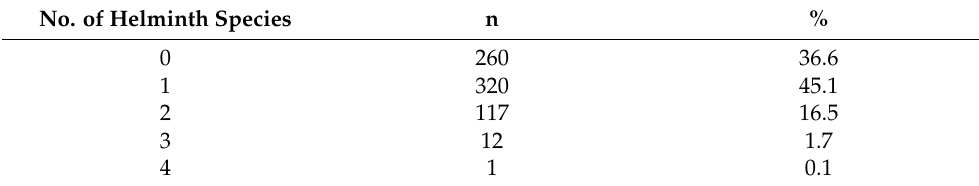
Table 7. Frequency of occurrence of the number of helminth species present in infracommunities of Microtus lusitanicus from Asturias.